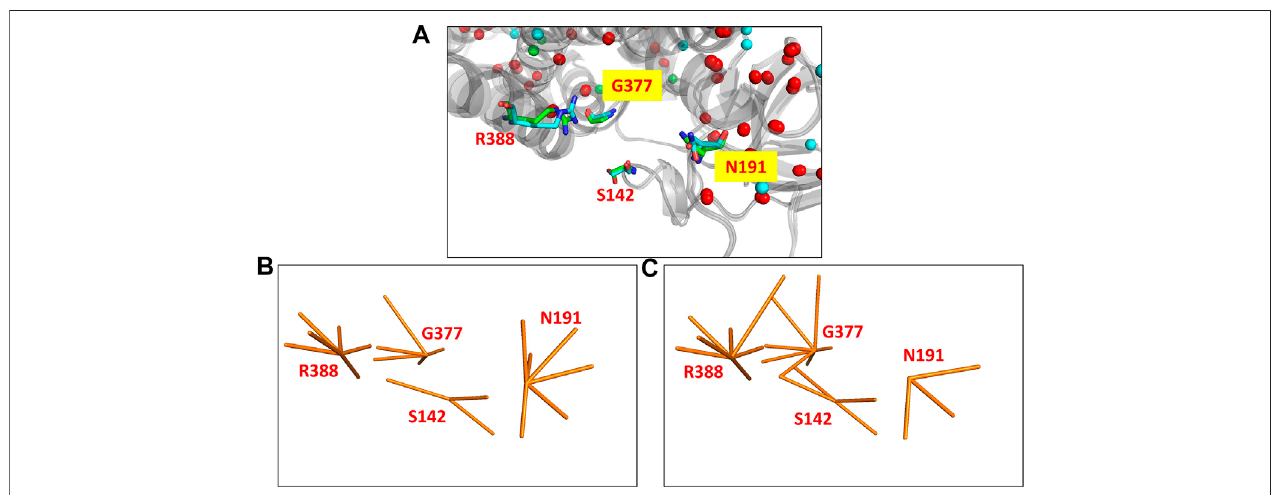
FIGURE2| Thefunctionalsiteinthecrystalstructuresofthewildtype(PDBID:1EGE)andmutant(PDBID:4P13)oftheMCADprotein. (A) Thefunctionalsiteofthe protein consists of four residues (S142, N191, G377, and R388) that are shown (using stick representation) in the superposed structures. The edges corresponding to these residues in the networks are shown in (B) the wildtype PSN and (C) the mutant PSN (using orange line representation). While N191 looses three edges, S142, G377, and R388 gain 1, 2, and 1 edges respectively.